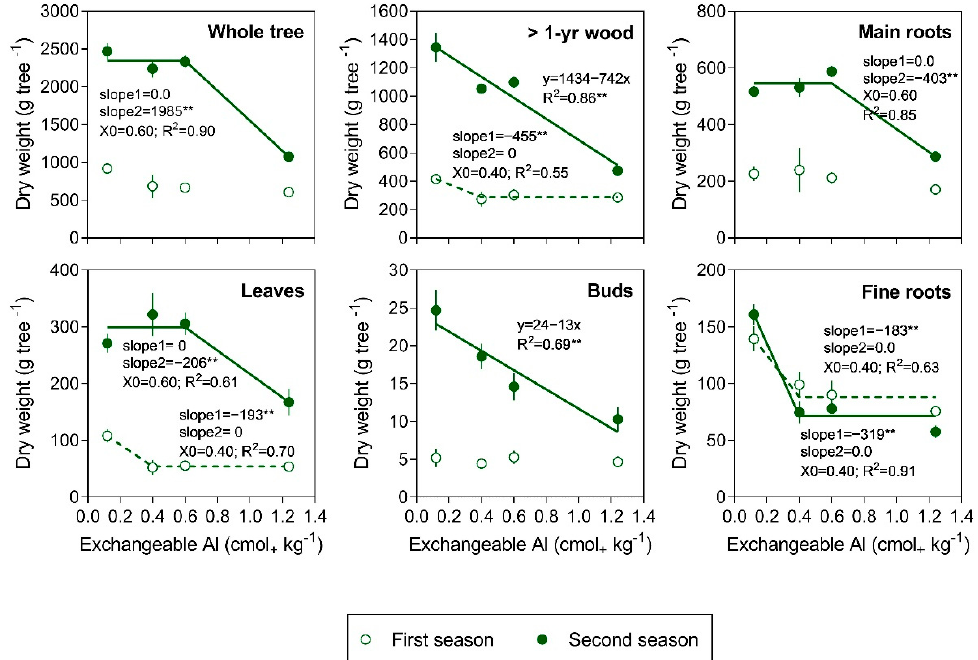
Figure 2. Relationship between biomass accumulation in the whole tree and in individual organs of sweet cherry trees and exchangeable Al in a volcanic soil. Values are the means, with standard errors as vertical bars ( n = 3). Significance of slopes: ** p < 0.01. In segmental regression, slope1 is the slope of the first line segment, slope2 is the slope of the second line segment, and X0 is the X value where the two line segments intersect.